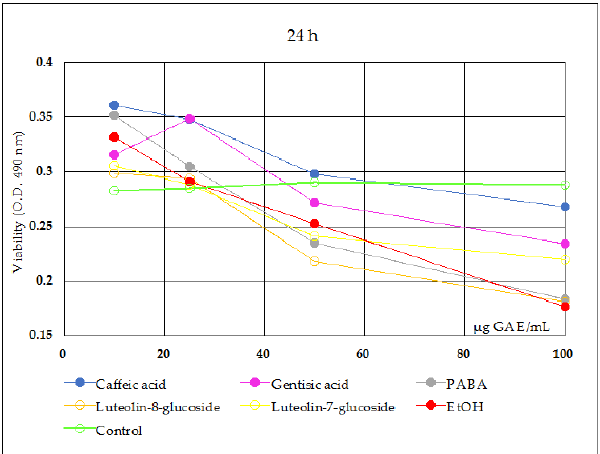
Figure 2. Caco-2 cell viability treated with the five reference compounds (phenolics), at 24 h.